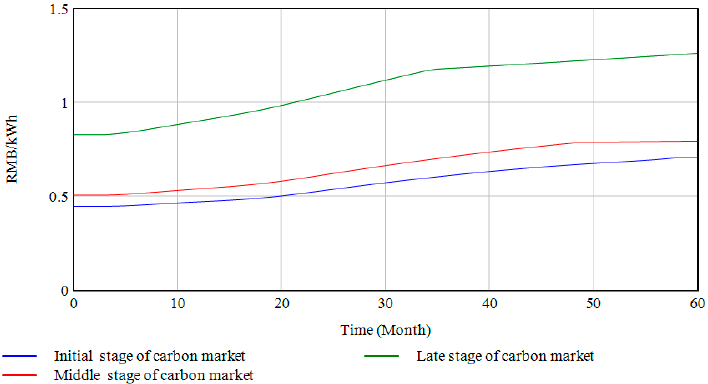
Figure 15. Trend of change in to-grid price of thermal power.